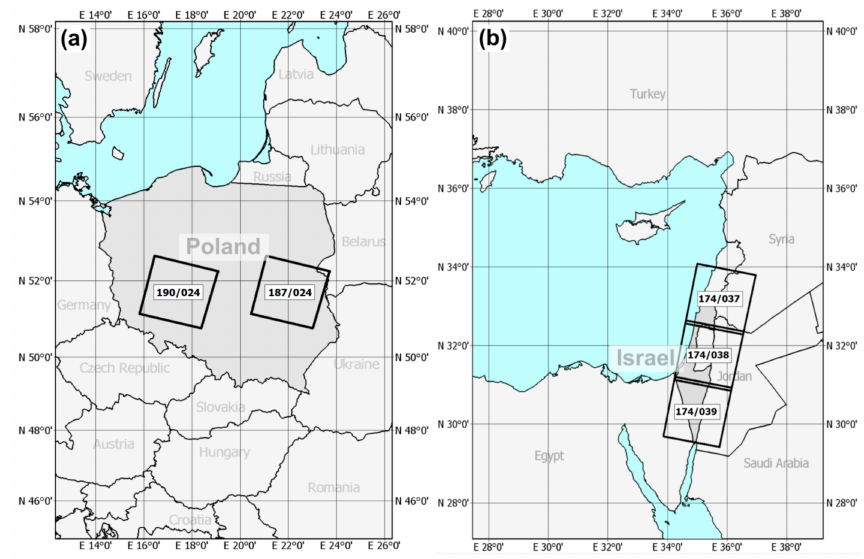
Figure 1. Location of Landsat scenes for ( a ) Poland and ( b )